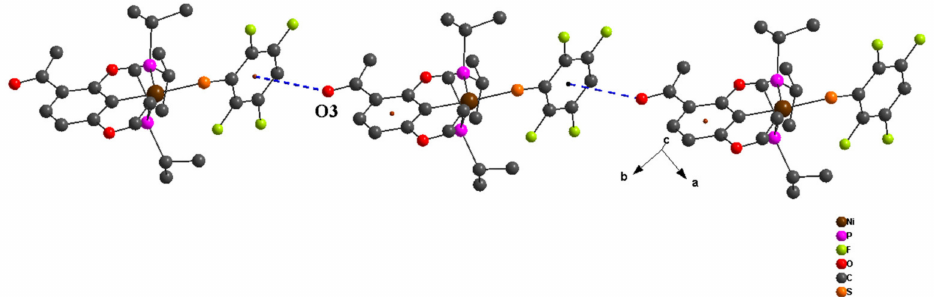
Figure 2. Fragment of the structure of compound ( 2 ) showing the formation of C7=O3 ··· Cg(C21–C26) interaction (dashed lines). The hydrogen atoms have been omitted for